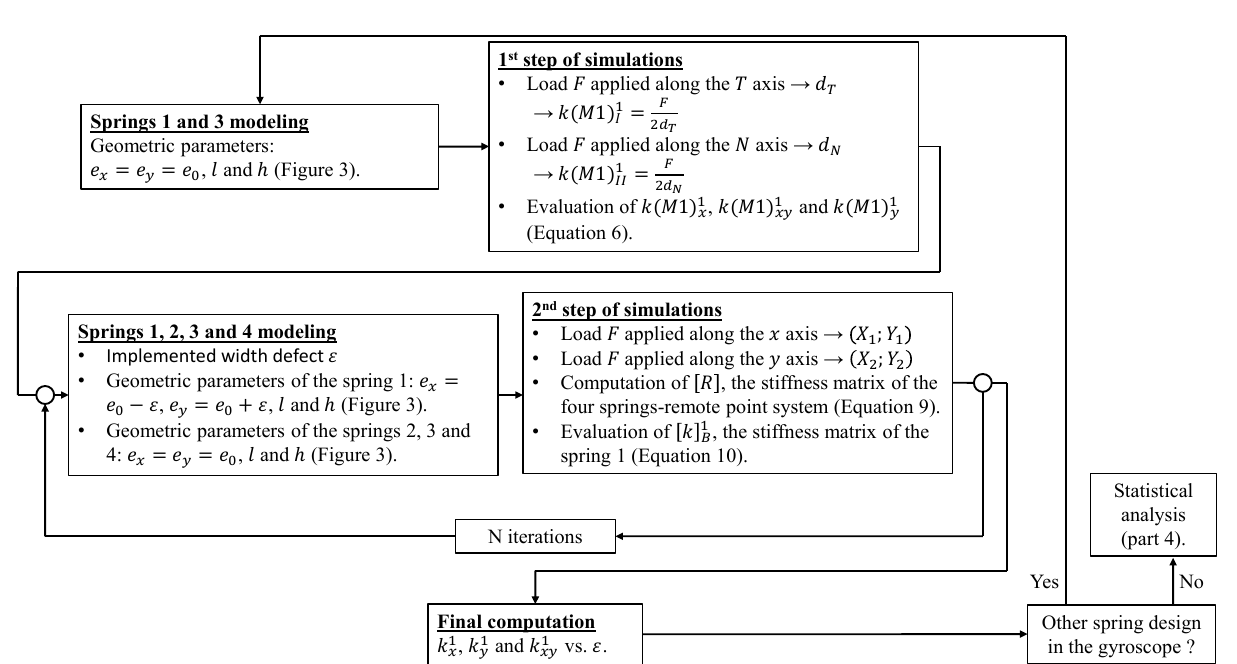
Figure 4. Synoptic diagram of the simulation procedure. Where ‘N iterations’ represents the number of iterations needed in order to run polynomial fits with a sufficient database for the values of (cid:4670)𝑘(𝑀1)(cid:4671) (cid:3003)(cid:2869) terms.